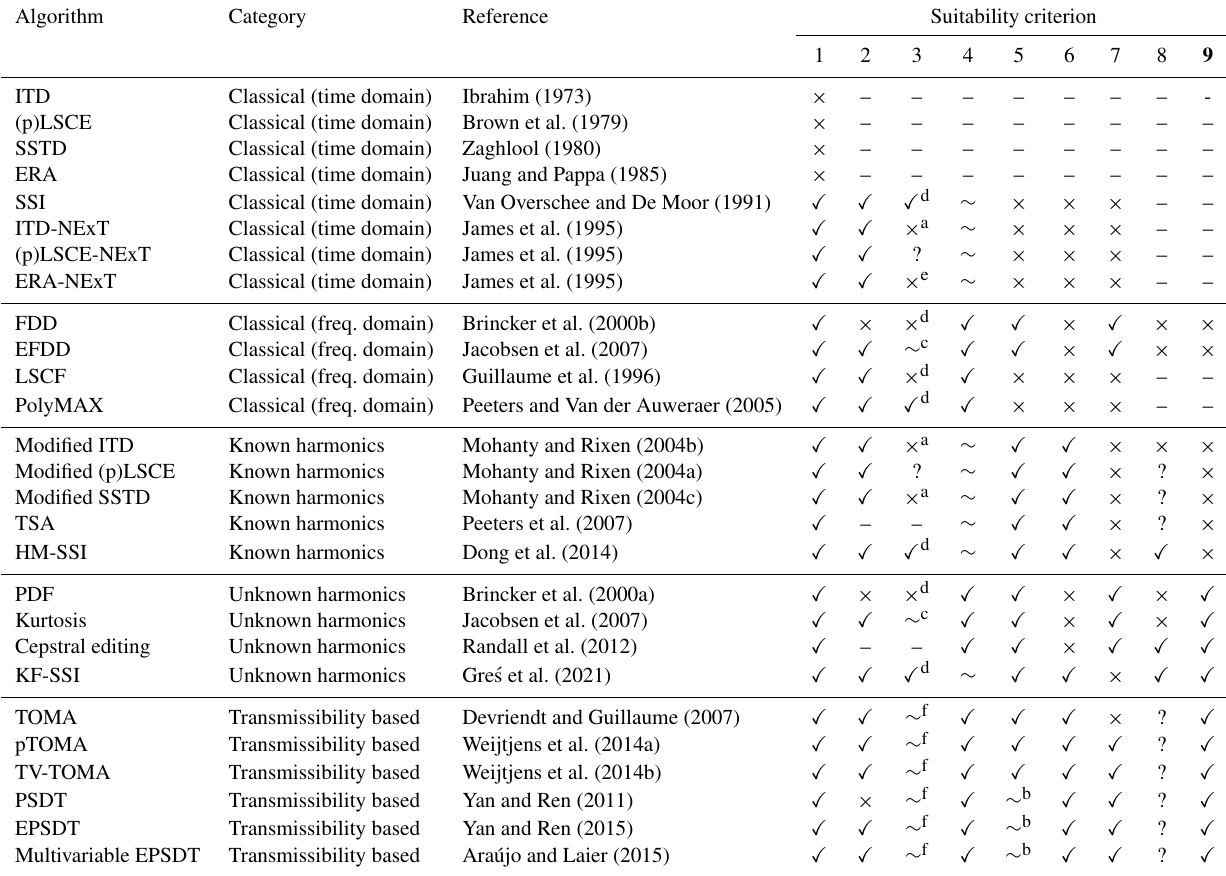
Table 2. Algorithm suitability for damping estimation from (operational) OWT data